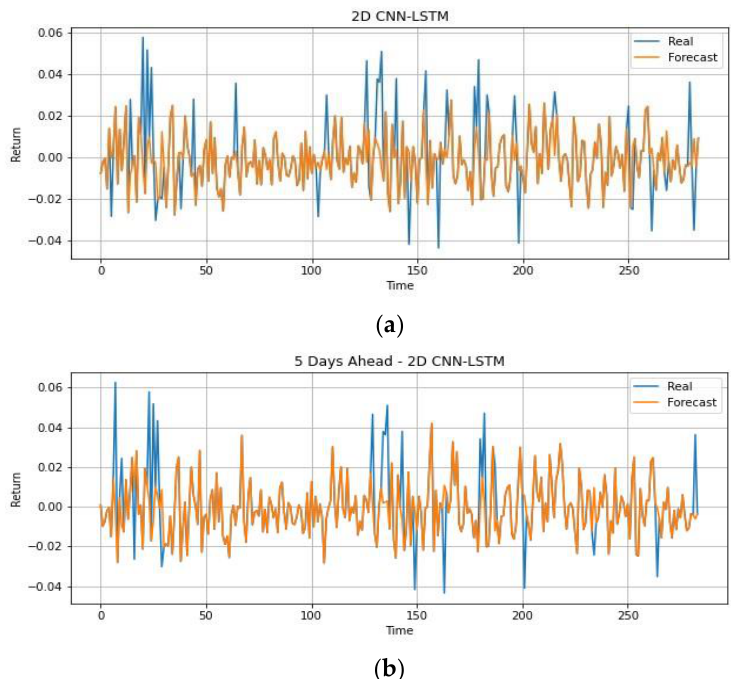
Figure 11. 2D CNN-LSTM Forecasting Result for One-Day- ( a ) and Five-Day-Ahead ( b ).